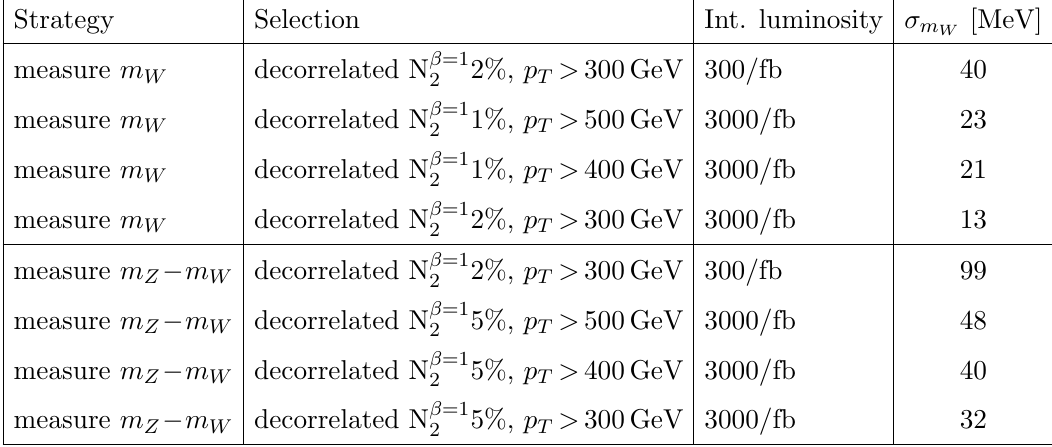
Table 3 . Statistical uncertainty of W mass measurement for di(cid:11)erent strategies and trigger selec- tions. The p T > 300 and p T > 400 selections will require new trigger